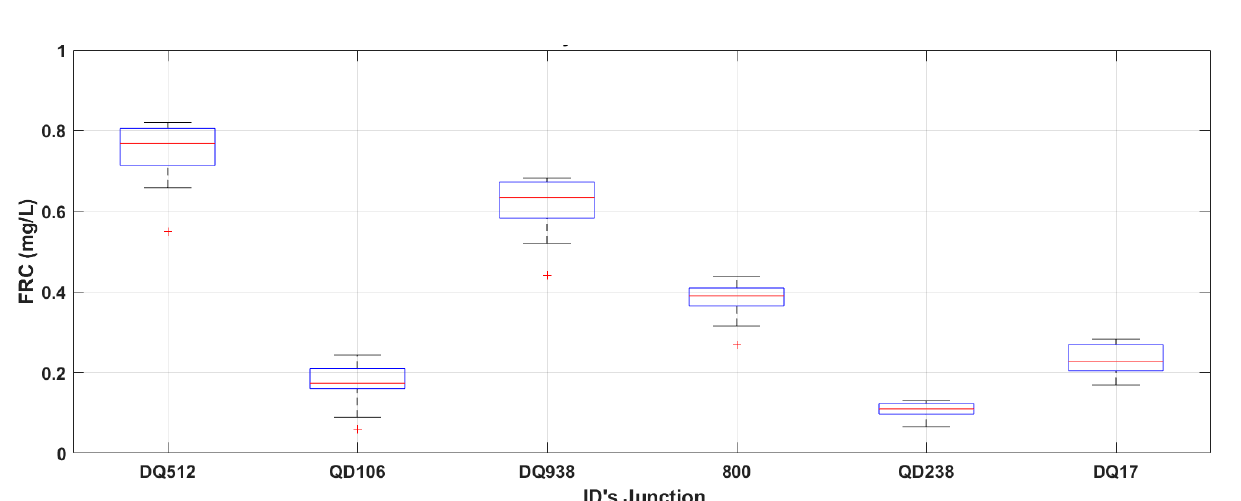
Figure 17. Box and whisker FRC distribution in Case 2 for critical